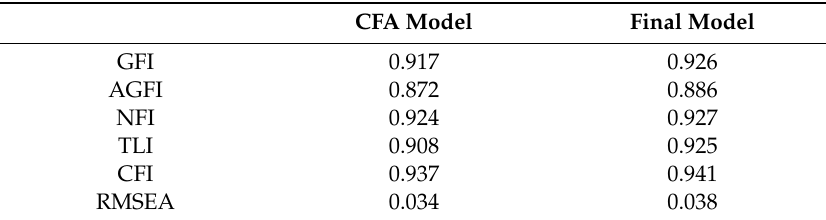
Table 3. Model fitness.